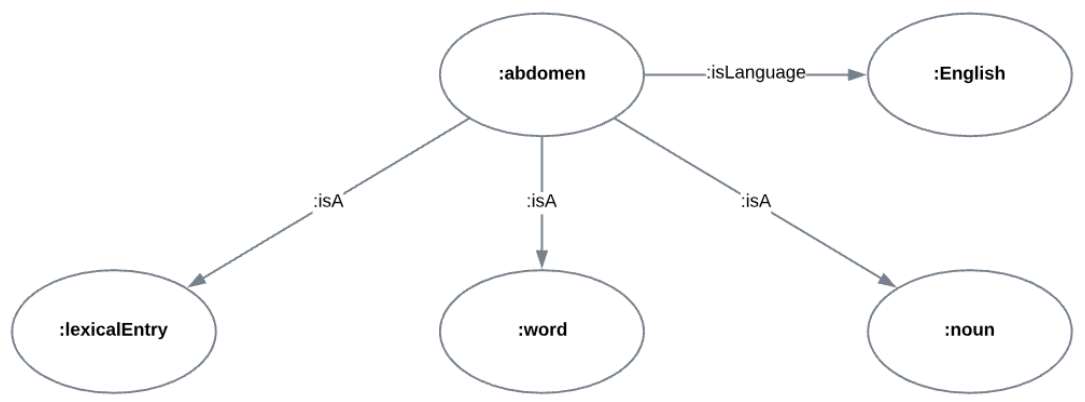
Figure 1. Visualisation of the lexical entry Abdomen , described using RDF triples.